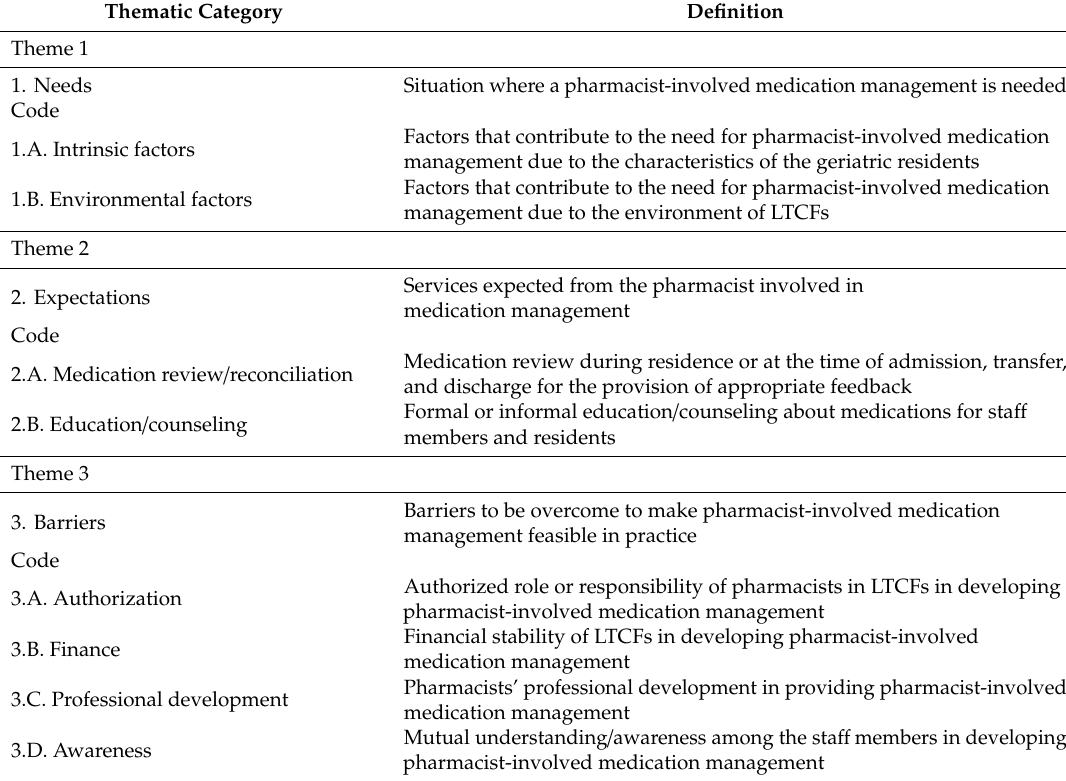
Table 3. Thematic categories and code